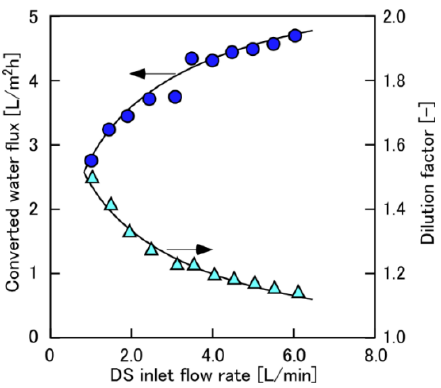
Figure 4. Converted water flux and dilution factor as a function of draw solution (DS) flow rate. PRO